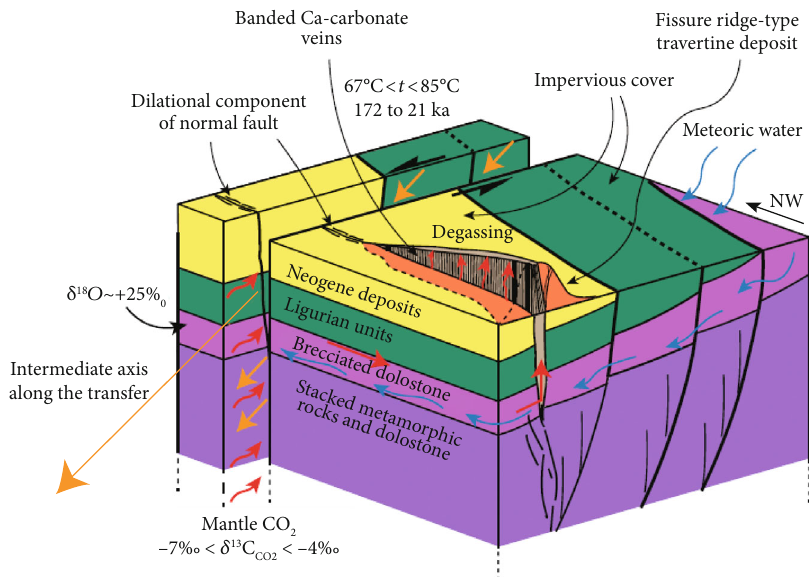
Figure 12: Not to scale cartoon showing the conceptual model of the hydrothermal fl uid circulation in the Iano area. Meteoric waters in fi ltrated at depth through dolostone and limestone forming the Late Triassic evaporite level that is exposed in the eastern basin shoulder. The heated fl uids interacted with the evaporite rocks, increase their δ 18 O, and mixed with mantle derived fl uids channeled along the main fault zones. The same fault zones (mainly N120 ° striking) channeled the fl uids up to the surface, where thermal springs, active since late Pleistocene, are depositing travertine bodies. Travertine fi ssure ridges and mounds are the main tectonometamorphic features occurring in the Iano